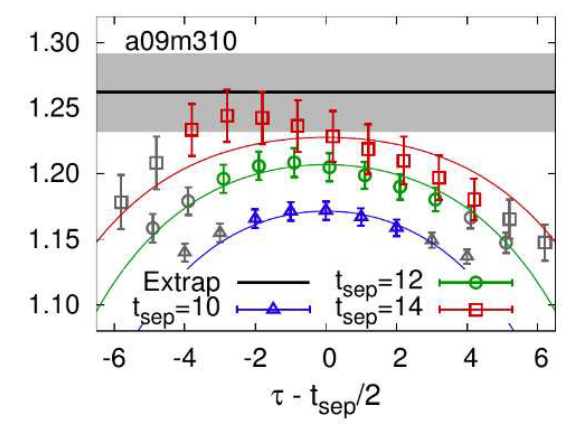
Figure 3. g u − d A extractions for a variety of t sep , the time separa- tion between the source and sink nucleon, and τ = t ins , the time where the current operator is inserted. Removal of excited-state contamination requires extrapolating to large t sep and looking for insensitivity in τ around t sep / 2. Results are from Ref.